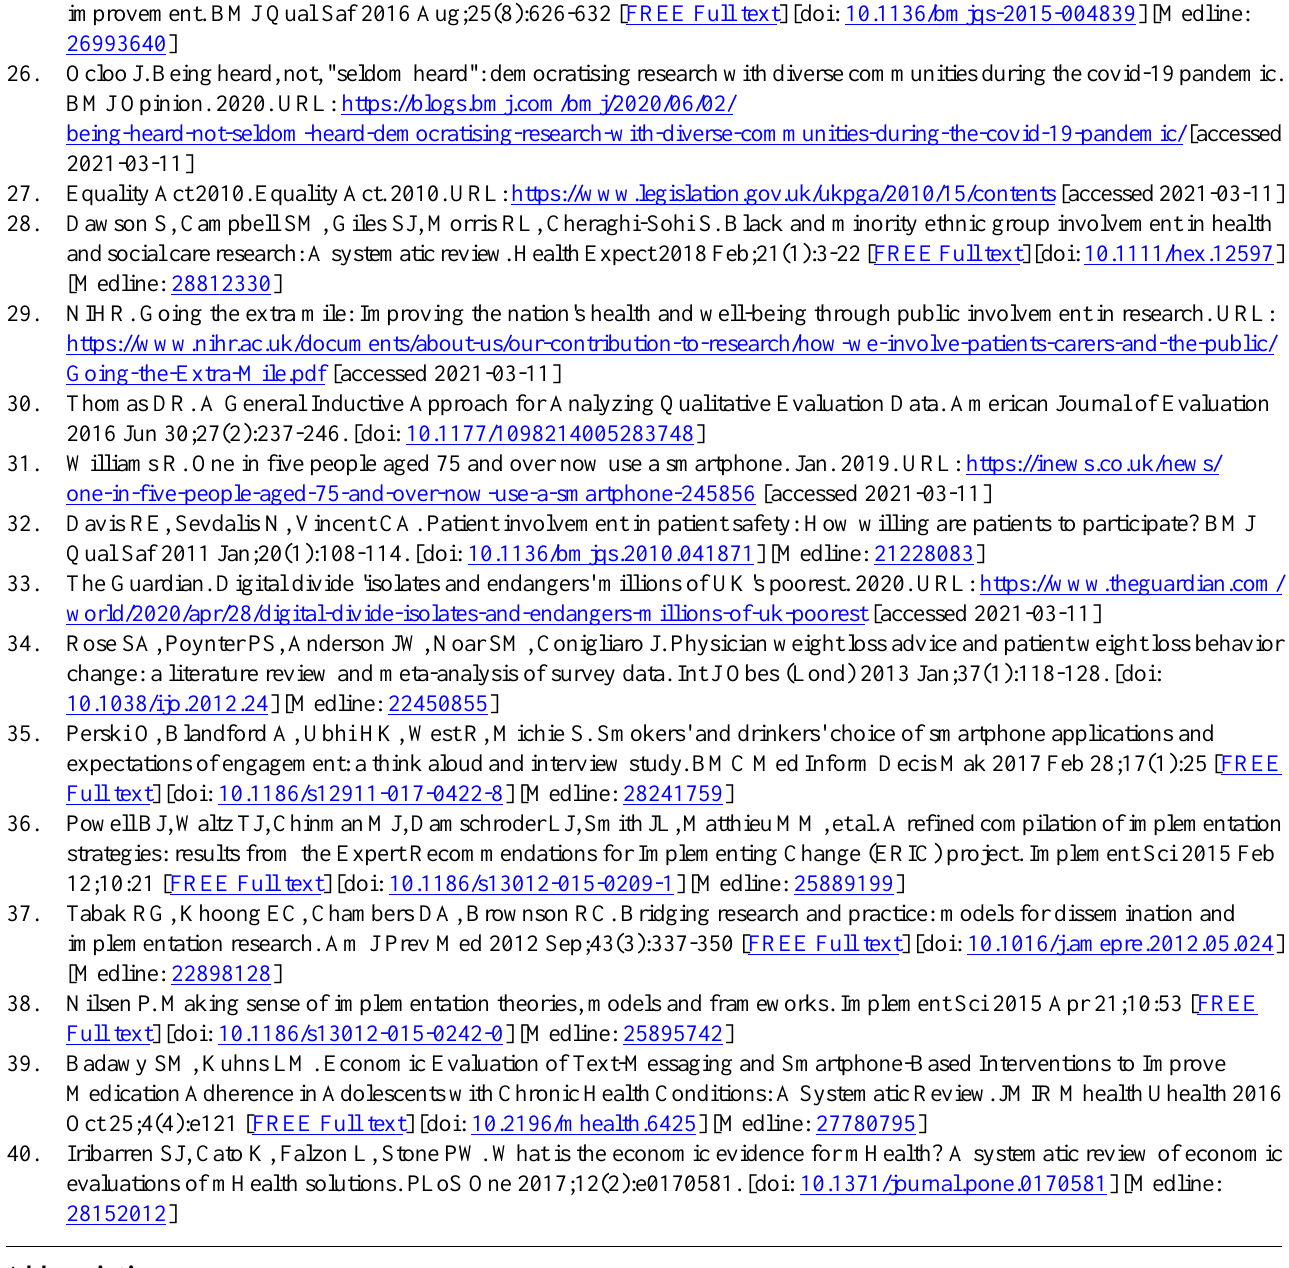
BAME: Black, Asian, and minority ethnic CIS: Centre for Implementation Science LGBT+: lesbian, gay, bisexual, transgender, and